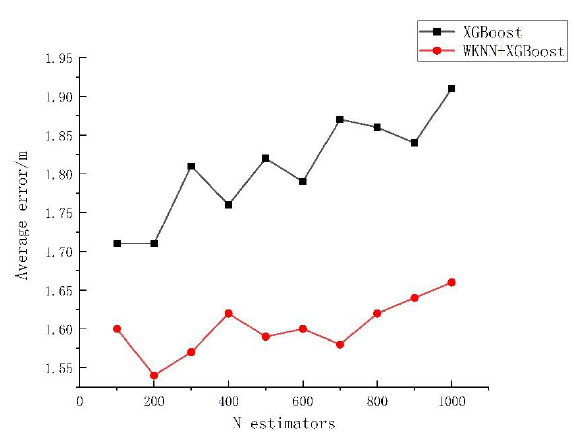
Sensors 2023 , 23 , x FOR PEER REVIEW Figure 5. The influence of the number of trees on the error. Figure 5. The influence of the number of trees on the error. Figure 5. The influence of the number of trees on the error.